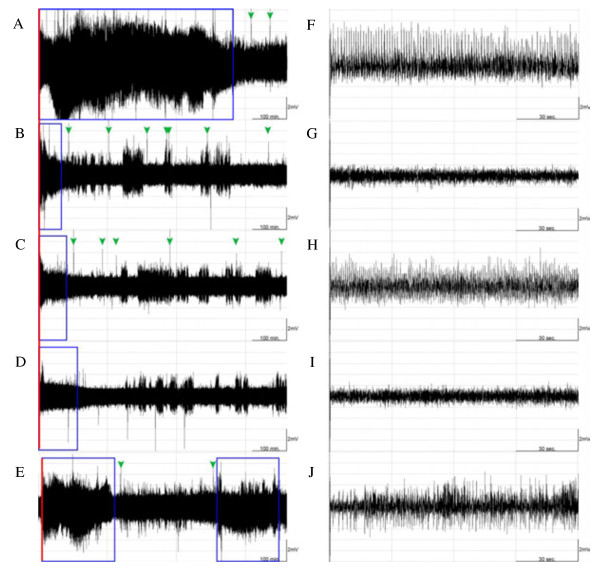
The effects of naloxone, naloxonazine, naltrindole and nor-binaltorphimine on the 100 Hz EA-induced exacerbation of epileptic activities. Panels A, B, C, D and E respectively depict the EEG signals recorded from the PFS + EA + pilocarpine group, naloxone + EA + pilocarpine group, the naloxonazine + EA + pilocarpine group, the naltrindole + EA + pilocarpine group, and the nor-binaltorphimine + EA + pilocarpine group, beginning from the dark onset of the dark period. Red lines indicate the time for pilocarpine administration (at the end of the 30-min EA stimulation). The blue boxes represent the epileptiform EEGs. Green arrowheads were the artifacts. The larger amplitudes, with EEG signals less than 2 mV, appeared in panels B, C and D were delta waves, which represent the state of slow wave sleep. Panels F, G, H, I and J were the enlarged figures which were respectively expanded the time scale from the panels A, B, C, D and E, and were recorded from the beginning of the dark period.